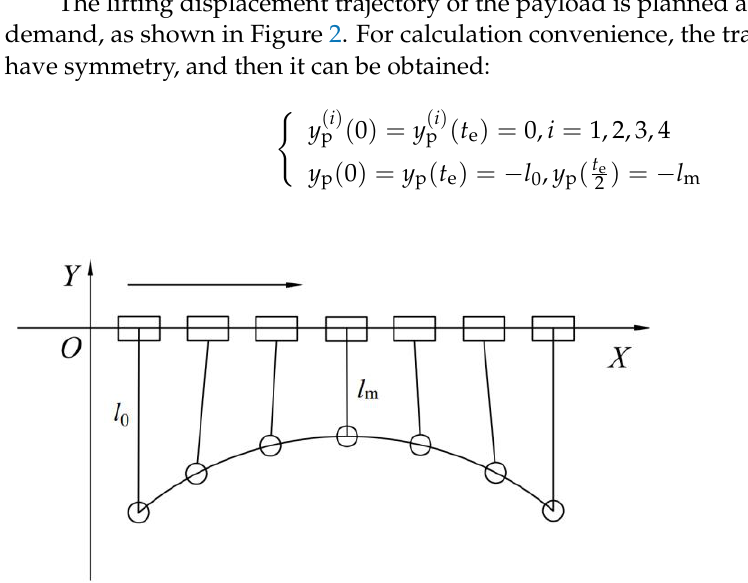
Figure 2. Transport process that accompanies lifting